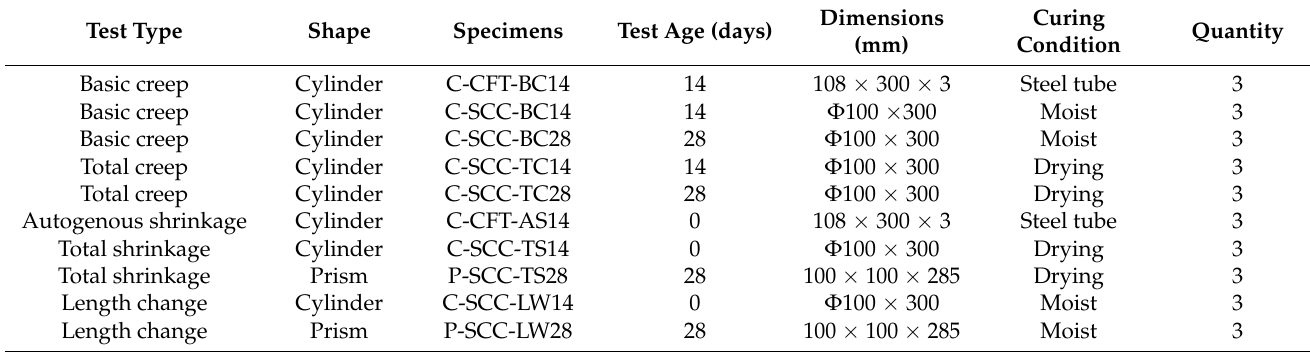
Table 2. Specimens design for creep and shrinkage